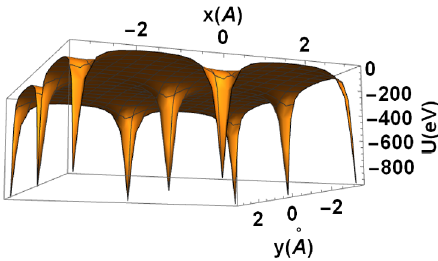
FIG. 1. Realistic continuous potential of the h 100 i axis of a W single crystal for electron